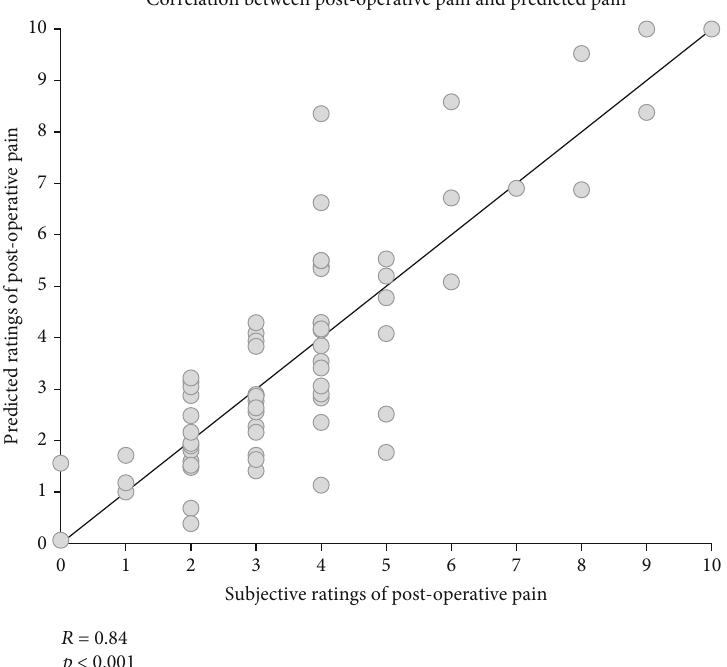
Figure 5: The correlation between subjective ratings of postoperative pain and the predicted ratings of postoperative pain by multiple linear regression with